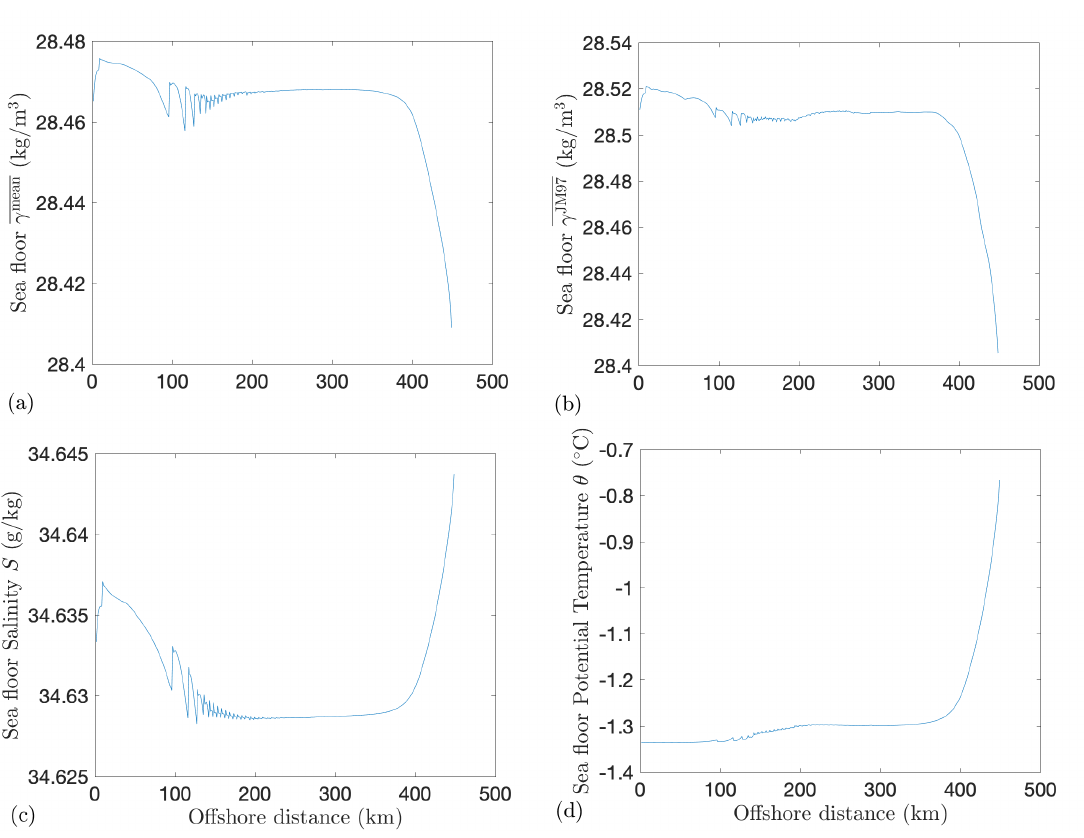
Figure 2. Time-/alongshore-mean ( a ) γ mean , ( b ) γ JM97 , ( c ) salinity and ( d ) potential temperature in the bottom-most model grid point, i.e., in the layer of dense water that descends down the continental slope [42], as a function of distance from the shore. This plot illustrates that the use of an independent reference dataset leads to a spurious local minima, e.g., around y = 200km, in γ JM97 . These are absent in γ mean , indicating that it more closely tracks Neutral Surfaces. The rapid density variations around y = 100km are due to “steps” in the model’s geopotential-coordinate representation of the continental